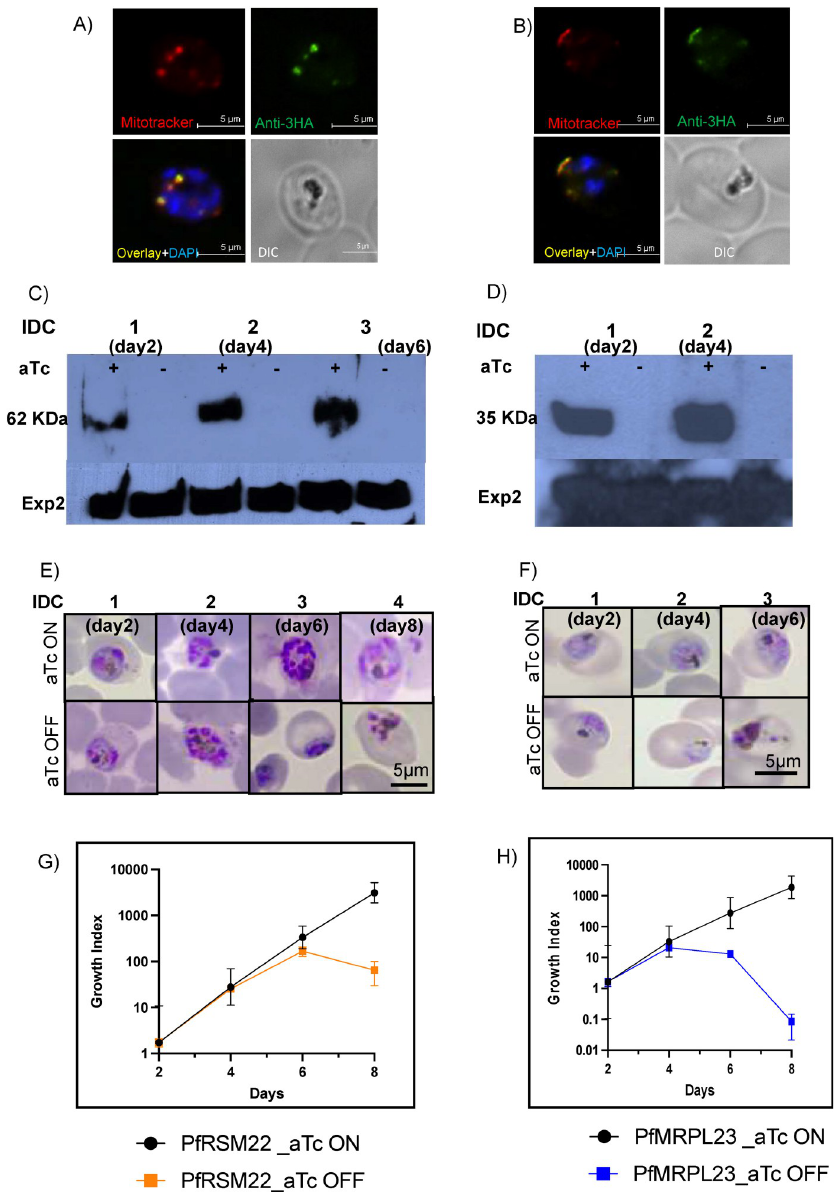
Fig 1. PfRSM22 and PfMRPL23 are localized to the mitochondrion and are essential for parasite survival. (A) Images from fluorescence microscopy showing colocalization of PfRSM22-3HA (green) with Mitotracker (red). (B) Colocalization of PfMRPL23-3HA (green) with Mitotracker (red). In A and B, the parasite nucleus is stained using DAPI (blue). (C) Western blot showing expression of PfRSM22-3HA protein (62 KDa) in the presence or absence of 250 nM aTc over 6 days (3 IDCs). (D) Western blot showing expression of PfMRPL23-3HA protein (32 KDa) in the presence or absence of 250 nM aTc over 4 days (2 IDCs). Pf-Exp2 (33 KDa) was used as a loading control. Representative images of Giemsa-stained D10-PfRSM22-3HA parasites (E) and D10-PfMRPL23-3HA parasites (F) at the trophozoite stage in the presence (aTc ON) and absence of aTc (aTc OFF). Quantification of D10-PfRSM22-3HA parasite growth (G) and D10-PfMRPL23-3HA parasite growth (H) over 8 days in the presence and absence of aTc. Growth index was calculated by multiplication of parasitemia with splitting factors over the time course. Data shown here is mean ± SD of n =